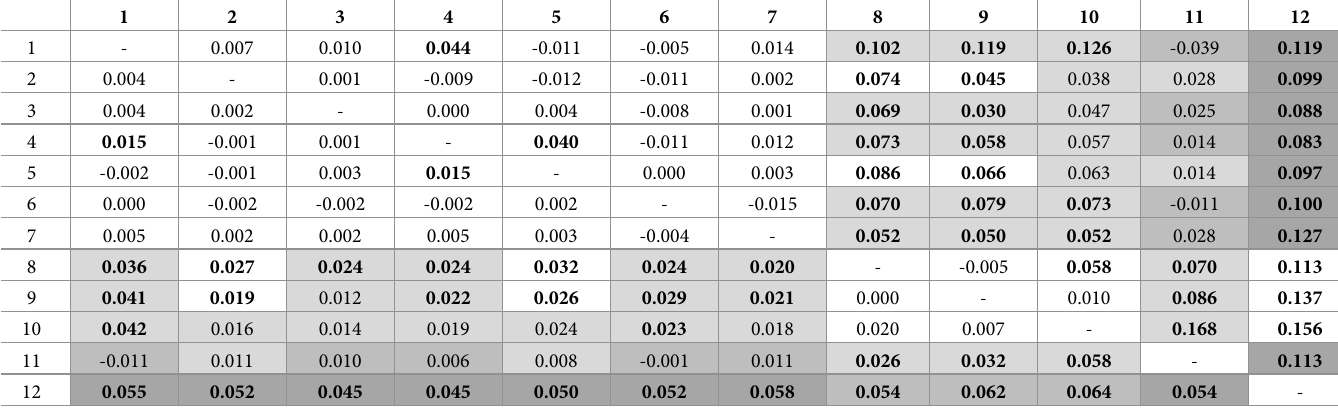
Table 4. Pairwise F ST and Jost’s D distances. F ST values are below, and Jost’s D above the